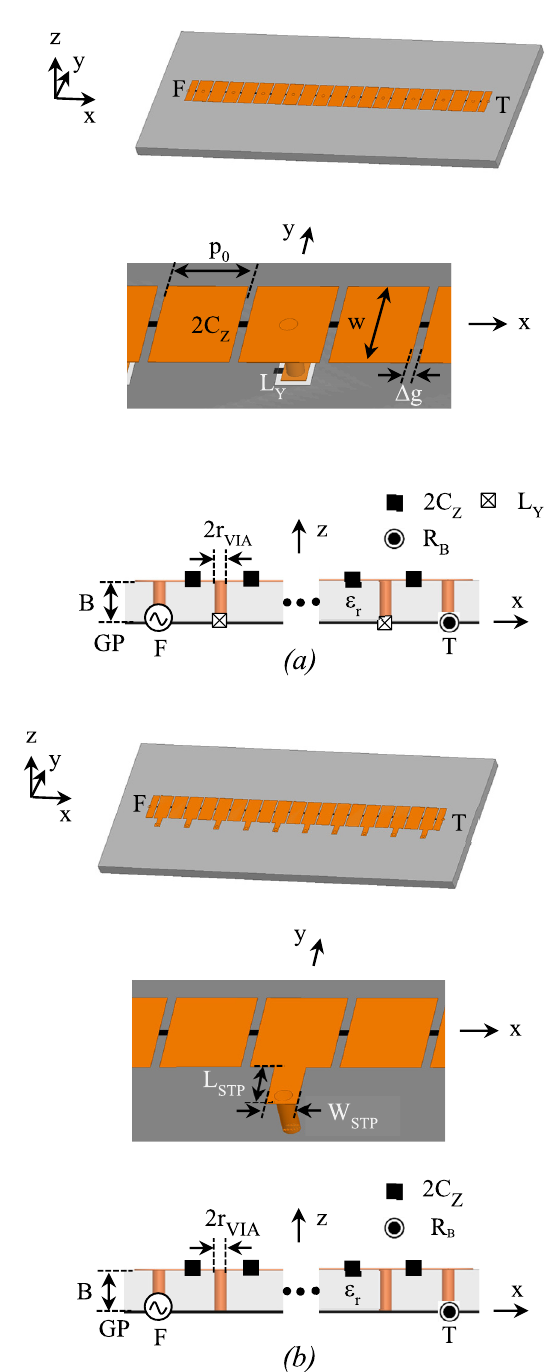
Fig. 2. Metalines. (a) Perspective view (upper), exploded view (middle) and side view (bottom) of a C-type metaline. (b) Perspective view (upper), exploded view (middle) and side view (bottom) of an N-type